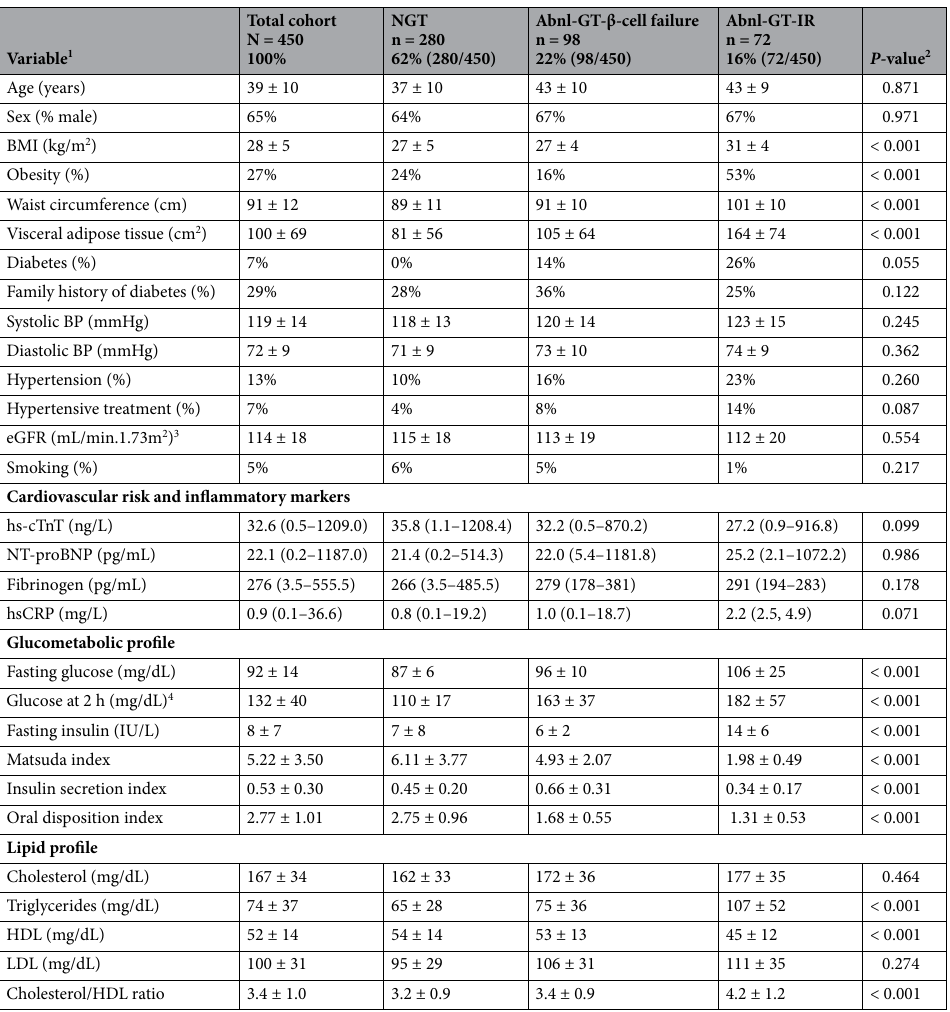
Table 1. Characteristics for the total cohort and by glucose tolerance status. 1 Data expressed as mean ± SD, except for Cardiovascular Risk and Inflammatory Markers which were expressed as the median and interquartile ranges. 2 Comparisons are of the Abnl-GT-β-cell failure vs Abnl-GT-IR groups; continuous variables compared by unpaired t-tests; categorical variables compared by Chi-square. 3 eGFR was calculated according to the eGFR-CKD-Epi formula. 4 Glucose at 2 h